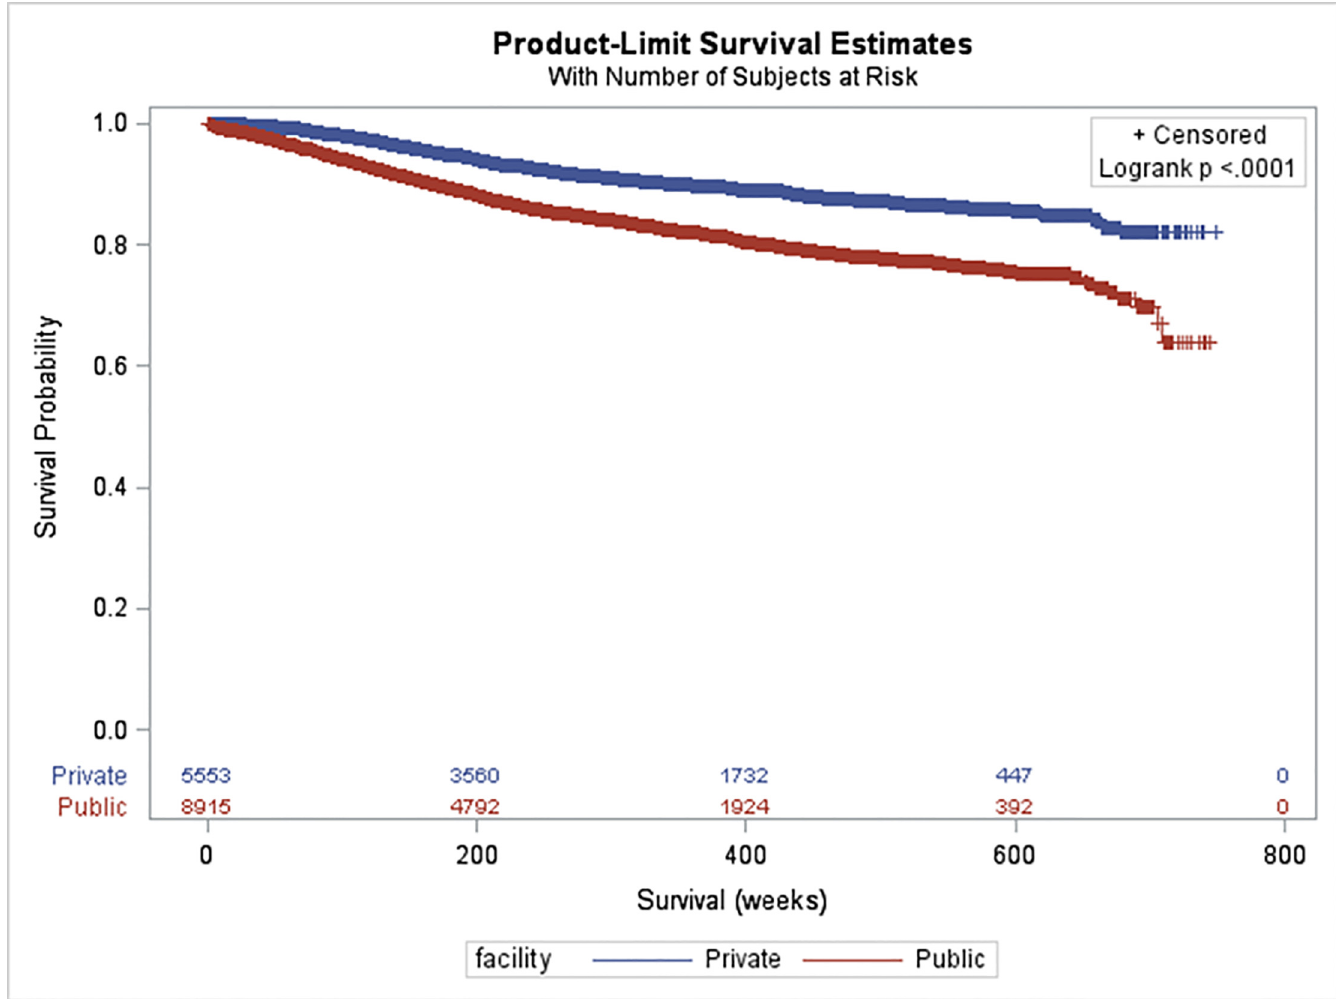
Fig 1. Breast cancer specific survival by health care facility